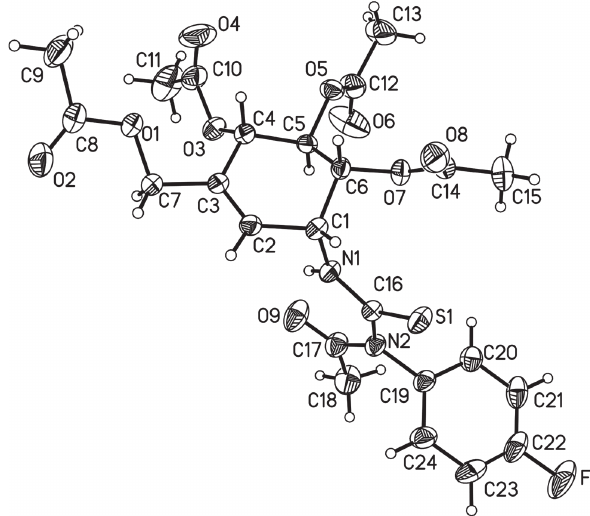
Table 1: Data collection and handling.